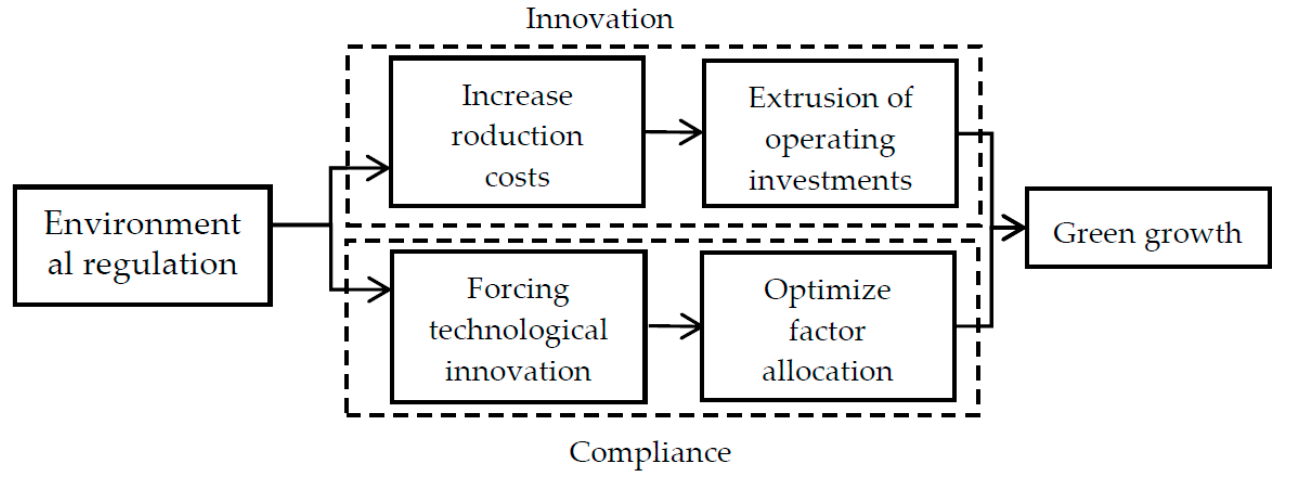
Figure 1. Effect path of environmental regulation on green growth.